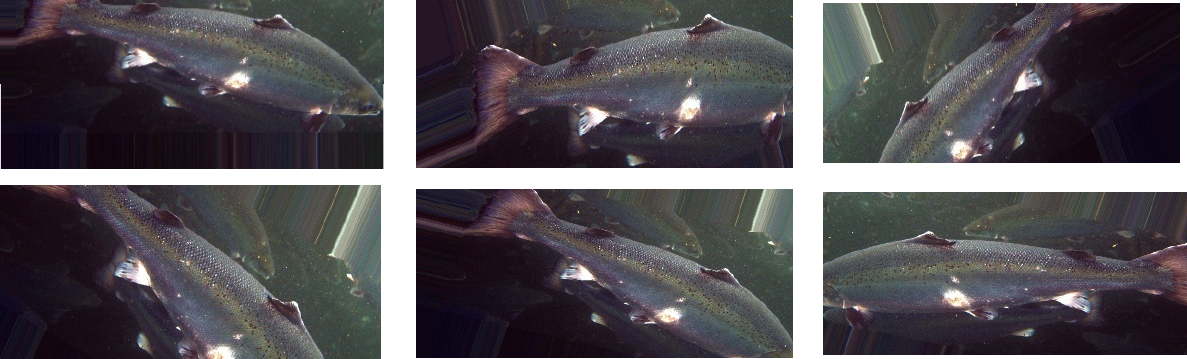
Figure 2. Example of augmented images.